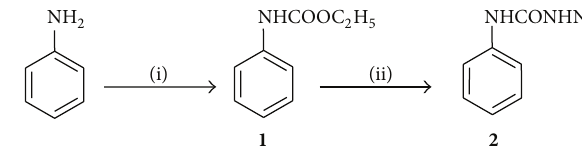
Scheme 1: Synthetic route for preparation of the semicarbazide 2 .